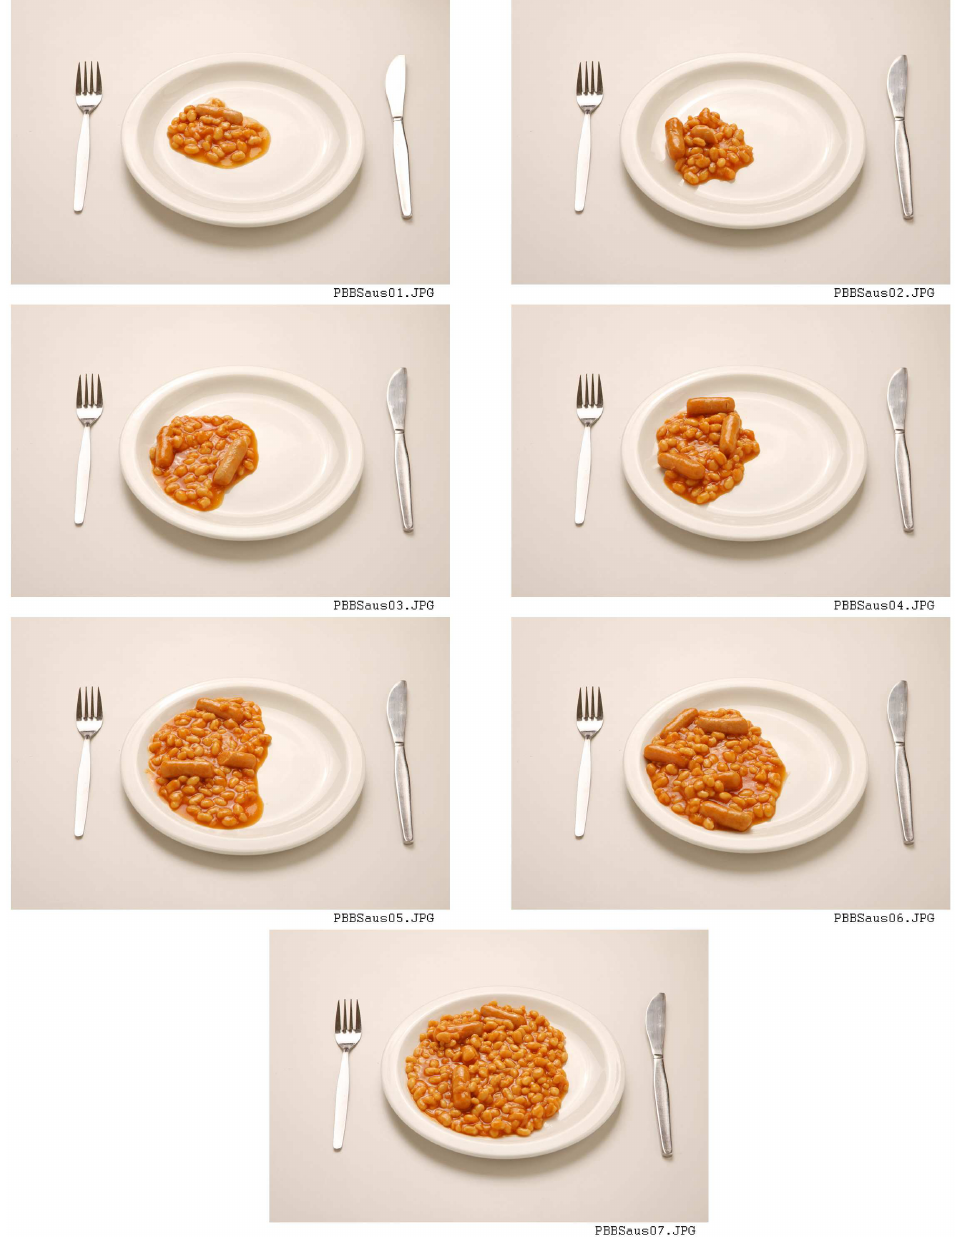
Fig 1. Example page from food atlas– 7 portion photographs for estimatesof amount served and